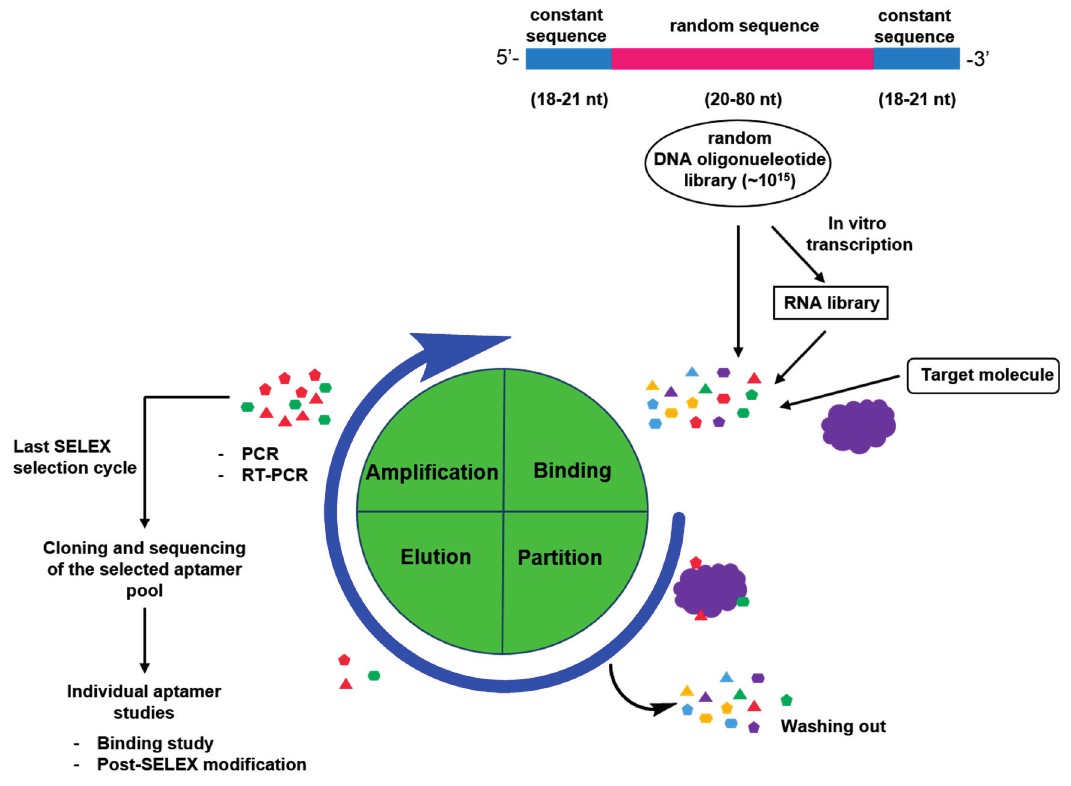
Figure 3. In vitro selection of target specific aptamer through SELEX screening